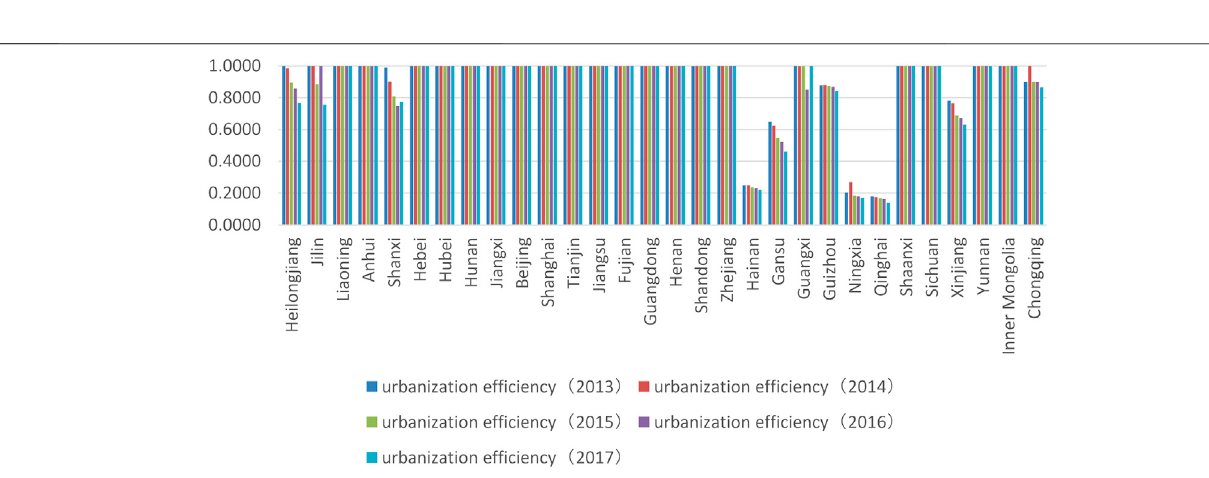
FIGURE 5 | 2013 – 2017 urbanization level ef fi ciency of provinces and